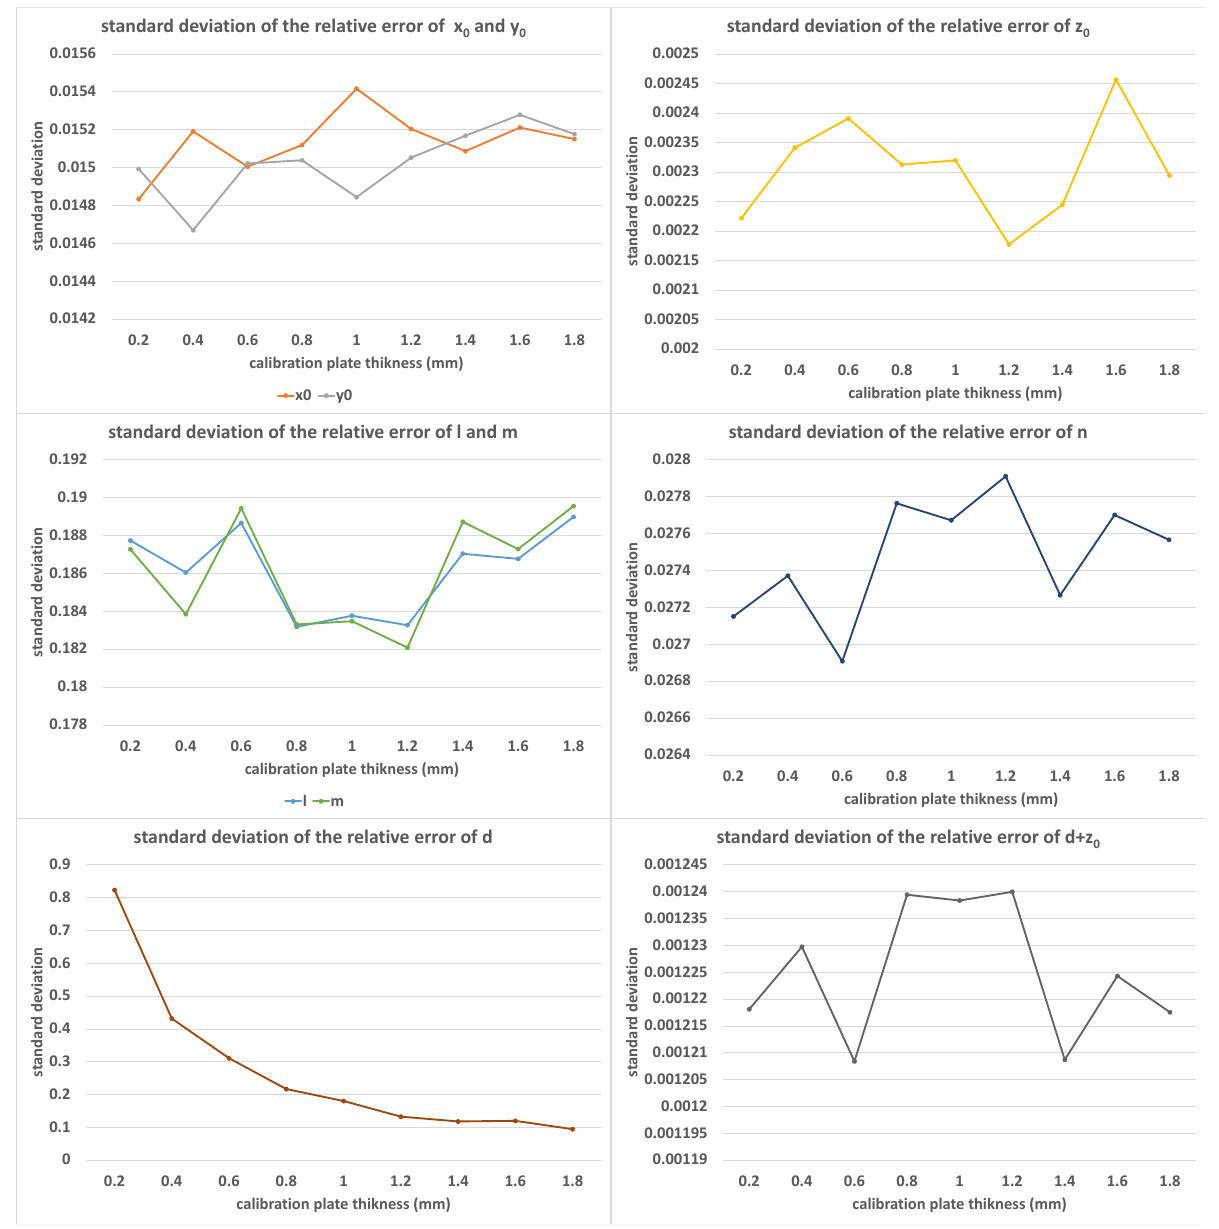
Figure 10. The standard deviations of relative errors of ( x 0 , y 0 , z 0 , l , m , n , d , d + z 0 ) with the increase in d ; the horizontal axis is measured in